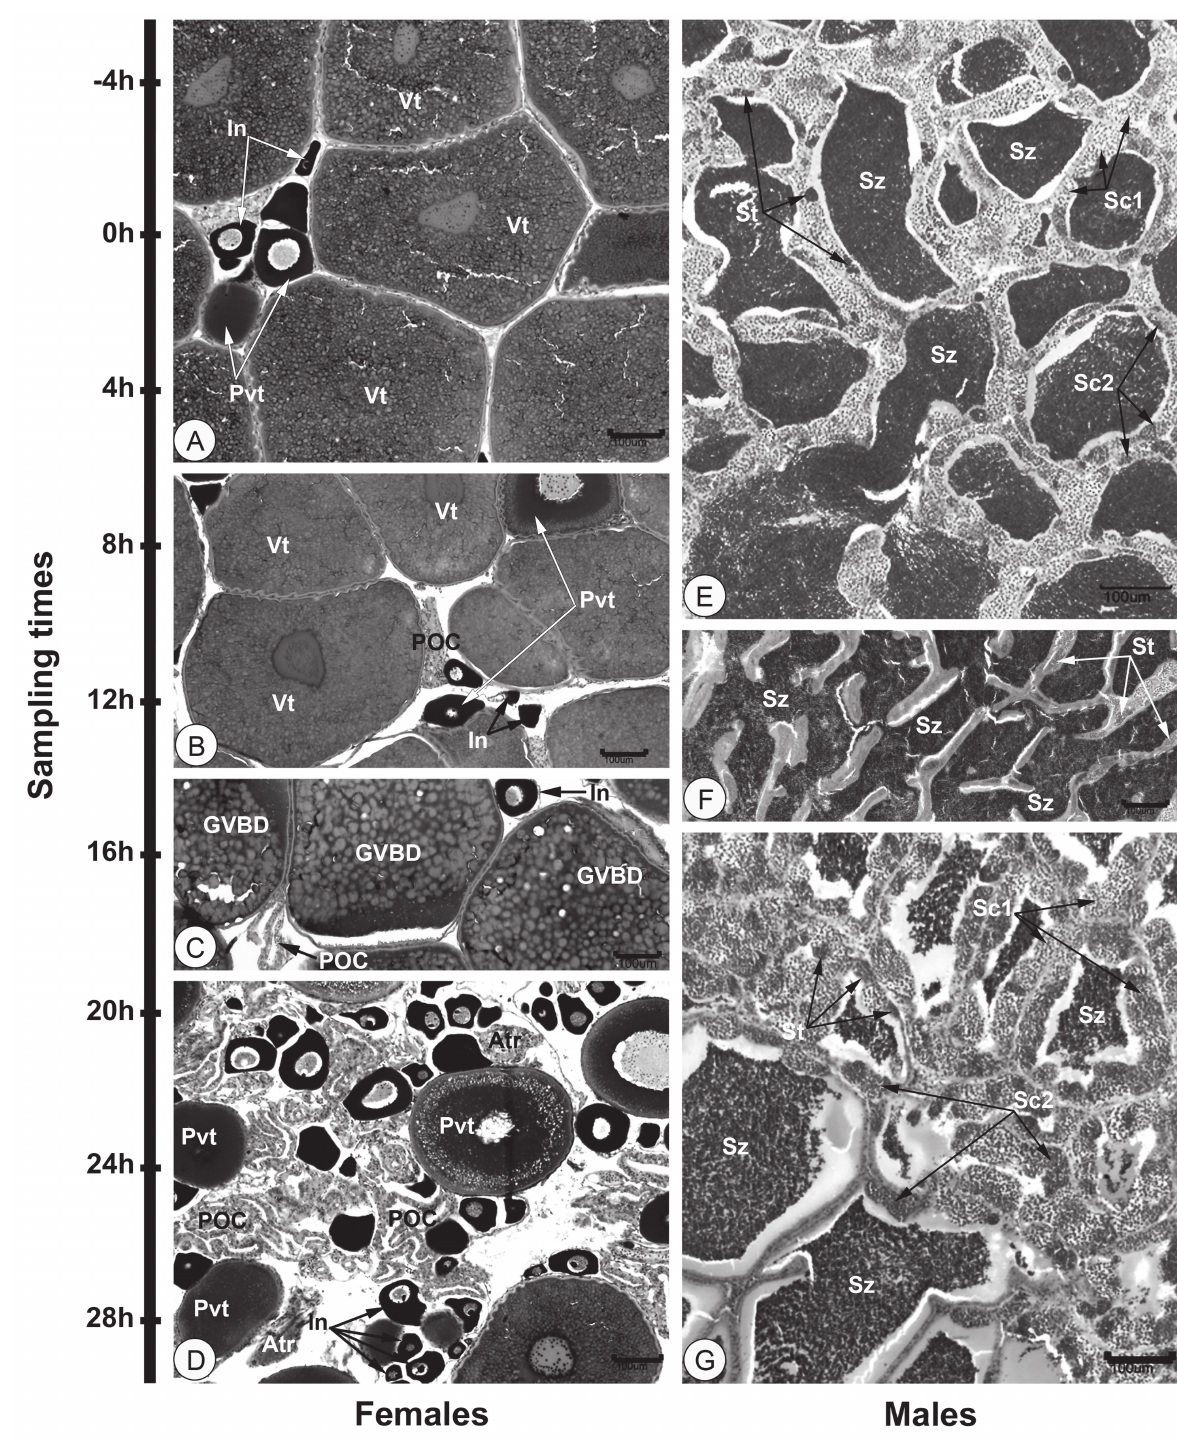
Fig. 1. Photomicrographs of gonads of Astyanax altiparanae over the sampling times (stained with hematoxylin-eosin). (A) Ovary in spawning capable phase from -4h to 4h; (B) Ovary in the same phase but with post-ovulatory complexes presents in 8h and 12h; (C) Ovary in the advanced actively spawning subphase of the spawning capable phase at 16h; (D) Ovary during regressing phase from 20h to 28h; (E) Testis in spawning capable phase from -4h to 8h; (F) Testis in the advanced actively spawning subphase of the spawning capable phase at 12h; (G) Testis returning the primary spawning capable phase from 16h to 28h. In - initial oocytes; Pvt - pre-vitellogenic oocytes; Vt - vitellogenic oocytes; POC - post-ovulatory complexes; GVBD - mature oocytes (oocytes with germinal vesicle breakdown); Atr - atresias; Sc1 - primary spermatocyte; Sc2 - secondary spermatocyte; St - spermatids; Sz -